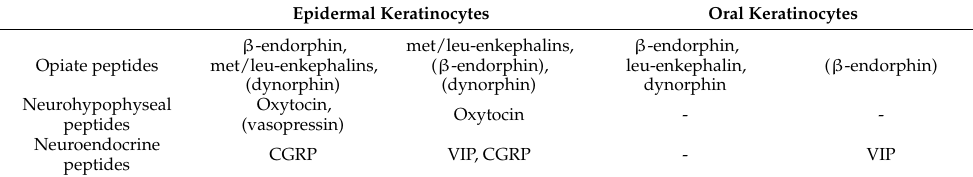
Table 1. Cont. Epidermal Keratinocytes Oral Keratinocytes Opiate